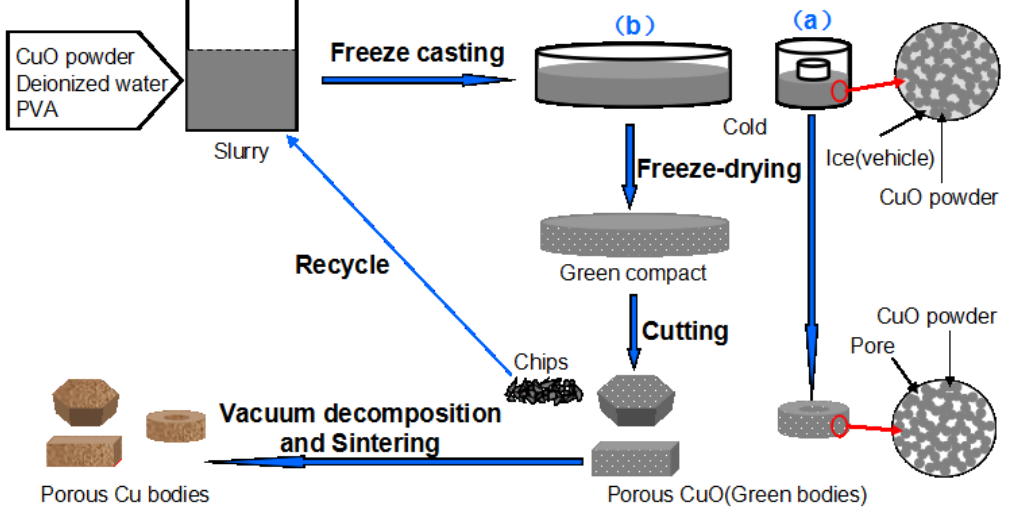
Figure 1. Schematic diagram of fabrication procedure of complex-shaped porous Cu bodies.